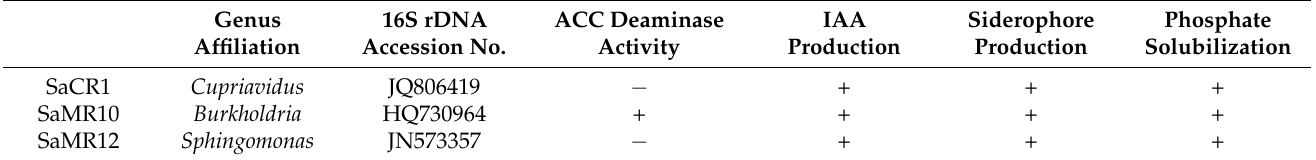
Table 1. Detailed information on bacterial strains used in this